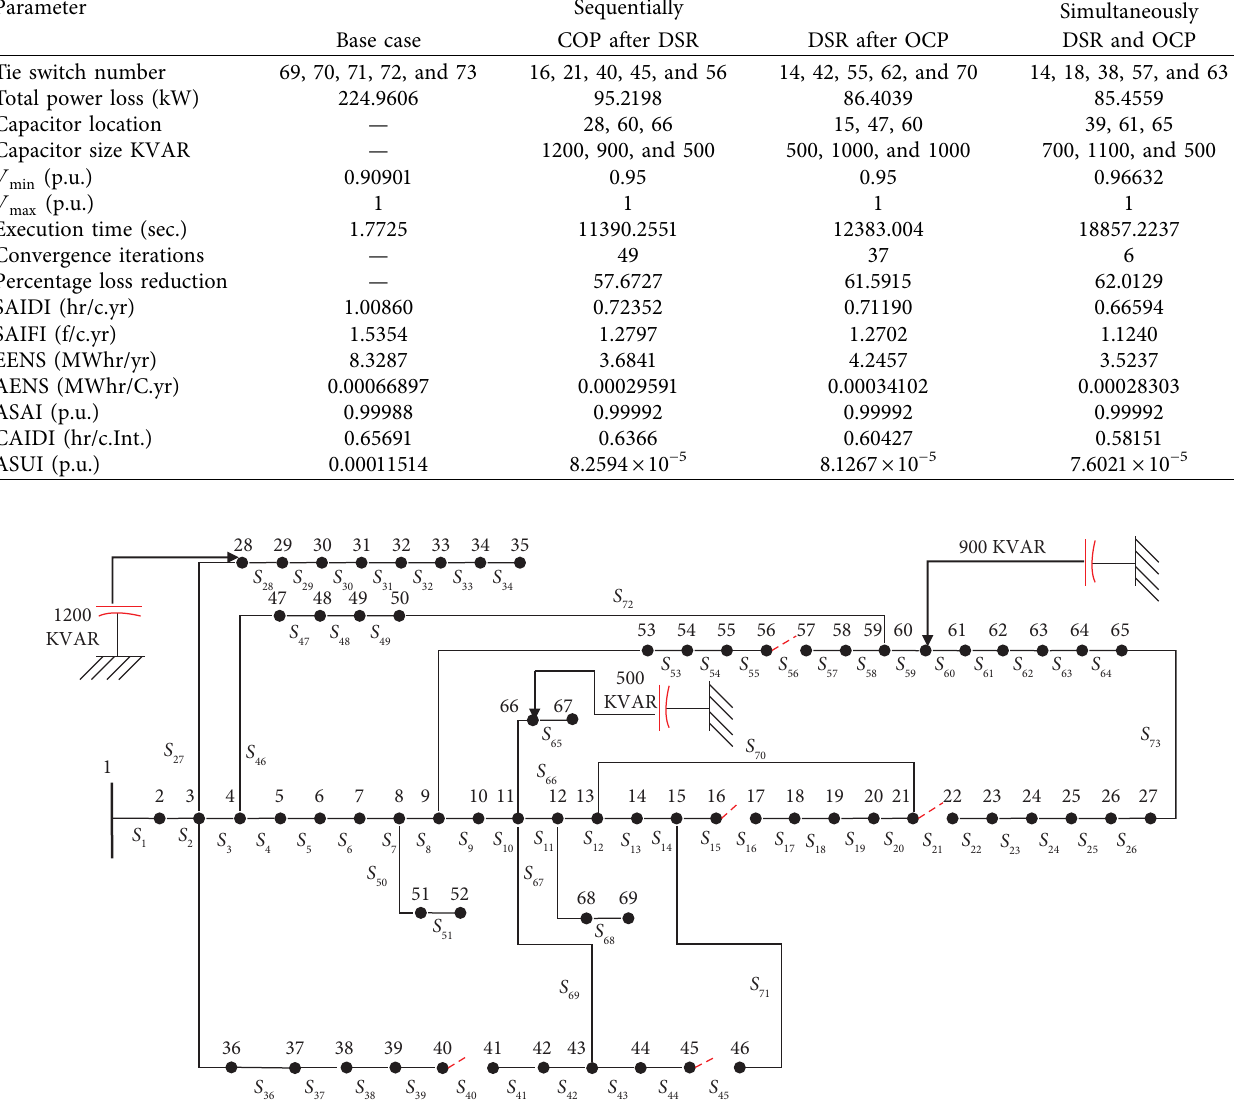
Figure 14: 69-bus IEEE system for scenario